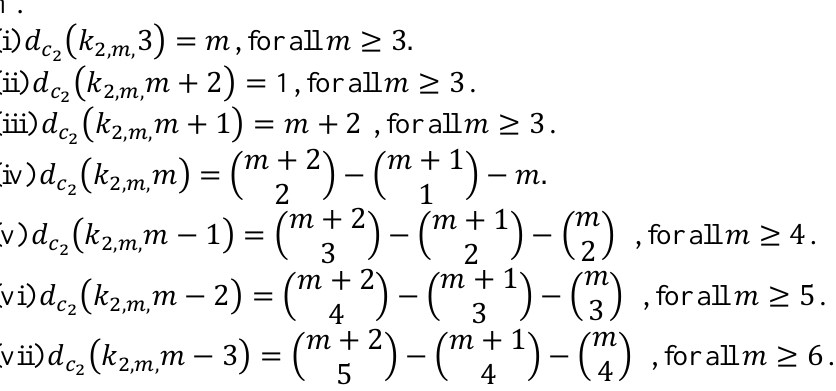
Table 1. 𝑑 (𝑘 𝑗) , the number of connected 2 − dominating sets of 𝑘 𝑐 2 2,𝑚, cardinality 𝑗